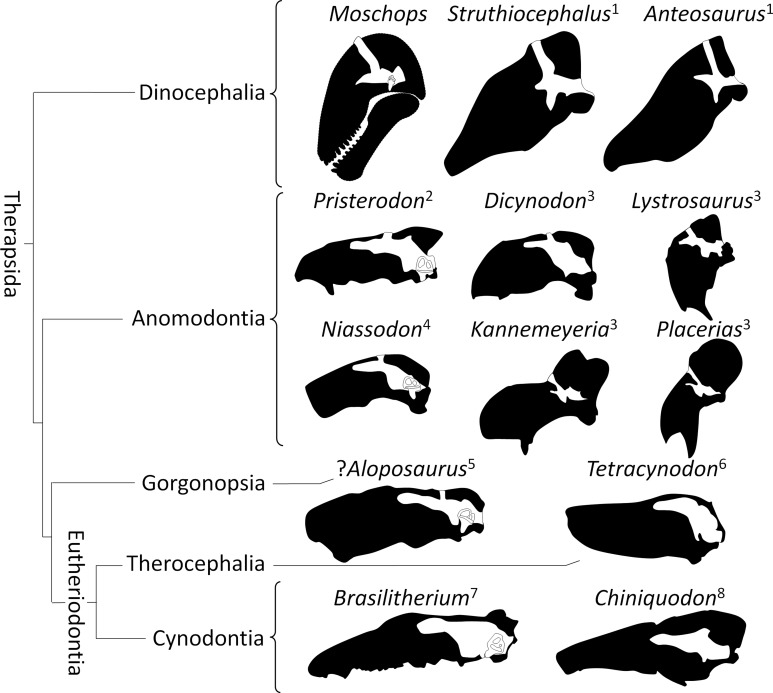
Orientation of the braincase (white) compared to that of the skull (black) in Therapsida.1, redrawn after Boonstra (1968); 2, redrawn after Laaß  (2015); 3, redrawn after Lehman (1961); 4, Castanhinha et al. (2013); 5, Araujo et al. (2016); 6, Sigurdsen et al. (2012); 7, Rodrigues, Ruf & Schultz (2013a); 8, Kemp (2009).